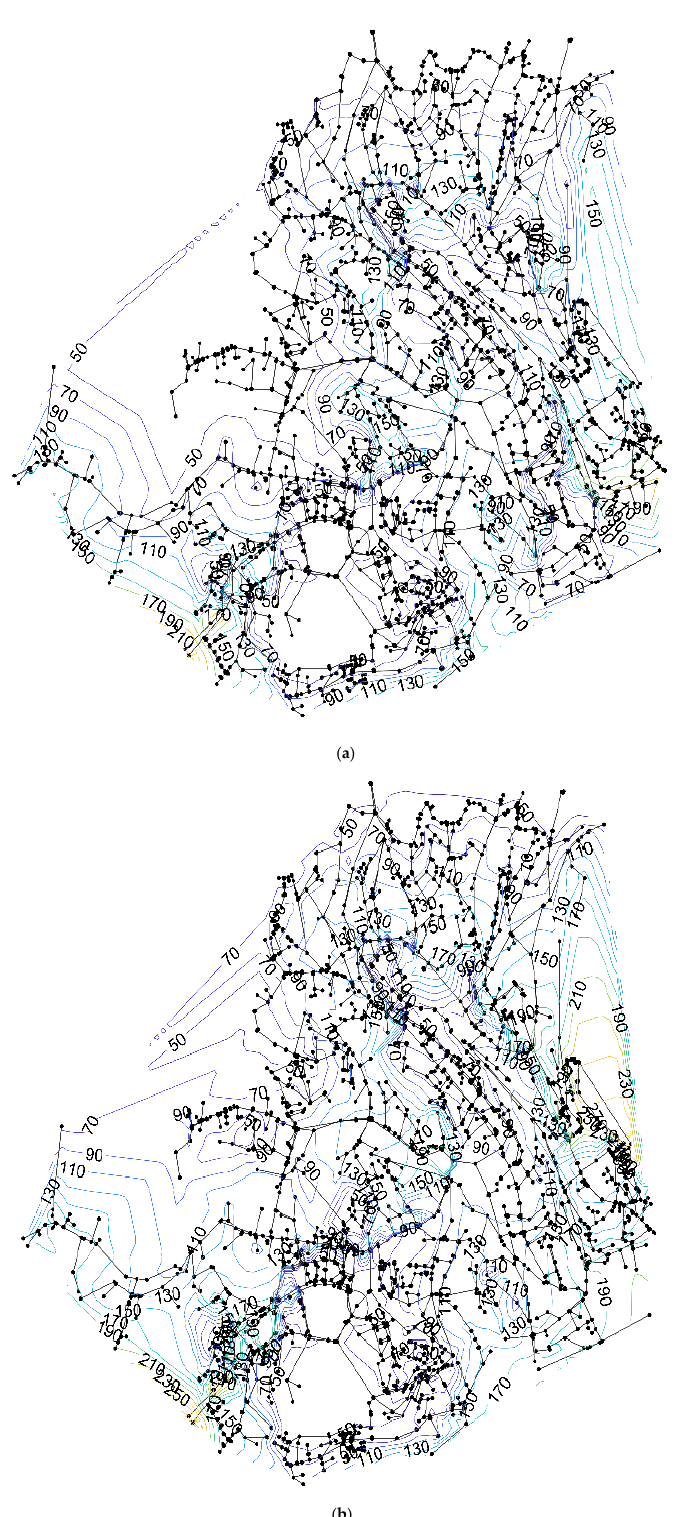
Figure A1. Pressure contour plot when devices (CMT and PRV) are installed ( a ) and without per- forming any pressure control strategy ( b ) for case (II).